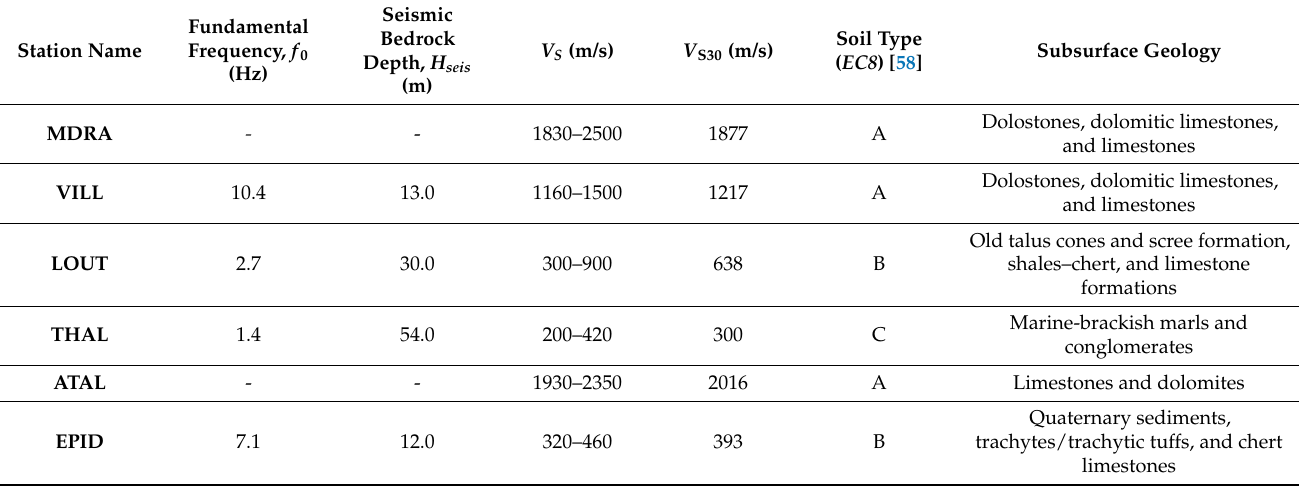
Table 5. Key parameters for site characterization of seismic